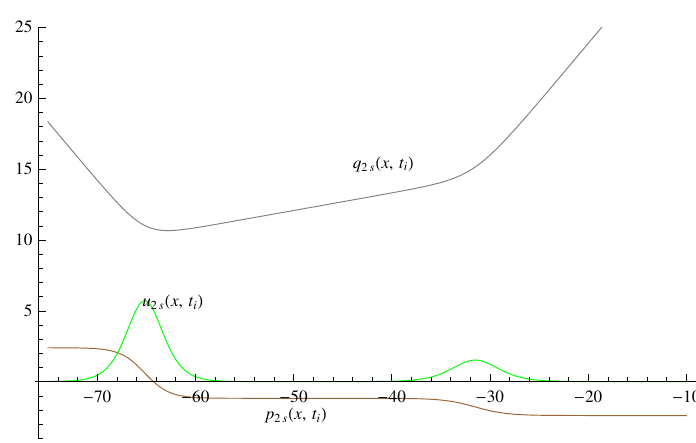
Figure 1 . The initial pro(cid:12)les of the (cid:12)elds q 2 s ( x; t i ), p 2 s ( x; t i ) and the 2-soliton u 2 s ( x; t i ) for initial time t i = (cid:0) 17 and parameter values (cid:15) 1 = 1 : 2 ; (cid:15) 2 = 0 : 9 ; b 1 = b 2 = c 1 = c 2 = 0 ; (cid:14) 1 = 1 ; (cid:14) 2 = 1 ; (cid:11) = 1 ; a 1 = 1 ; a 2 = 0 : 8 ; k 1 = 0 : 8 and k 2 = 0 :